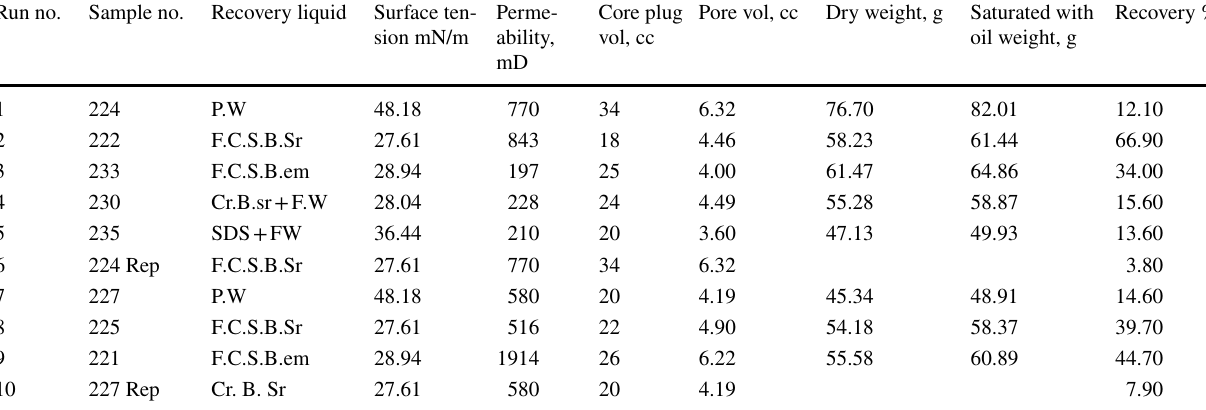
Table 8 Effect of biosurfactant and bioemulsifier on oil recovery Run no. Sample